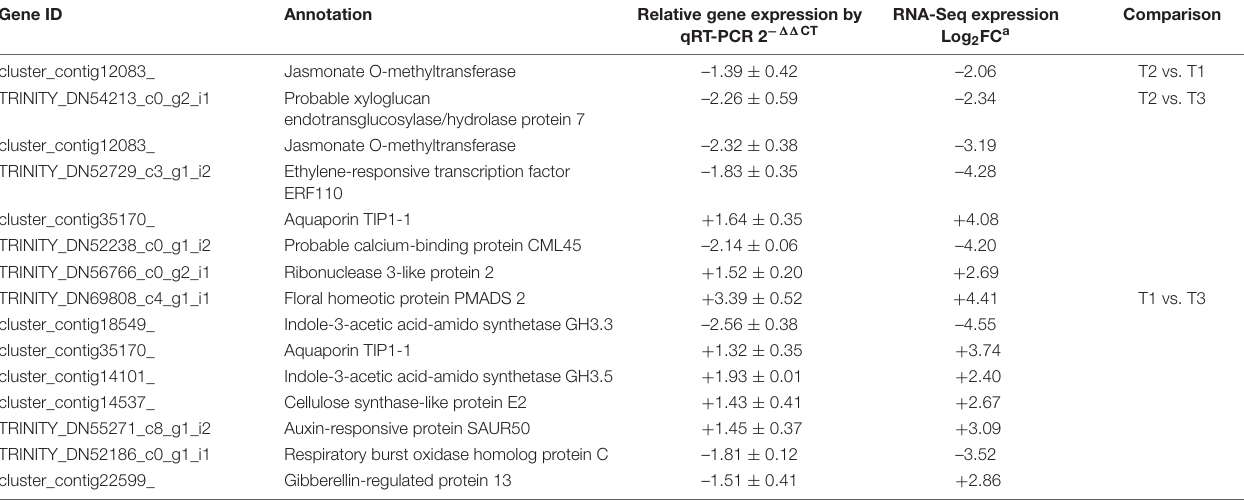
TABLE 5 | The qRT-PCR with the differential expressed genes. Gene ID Annotation Relative gene expression by